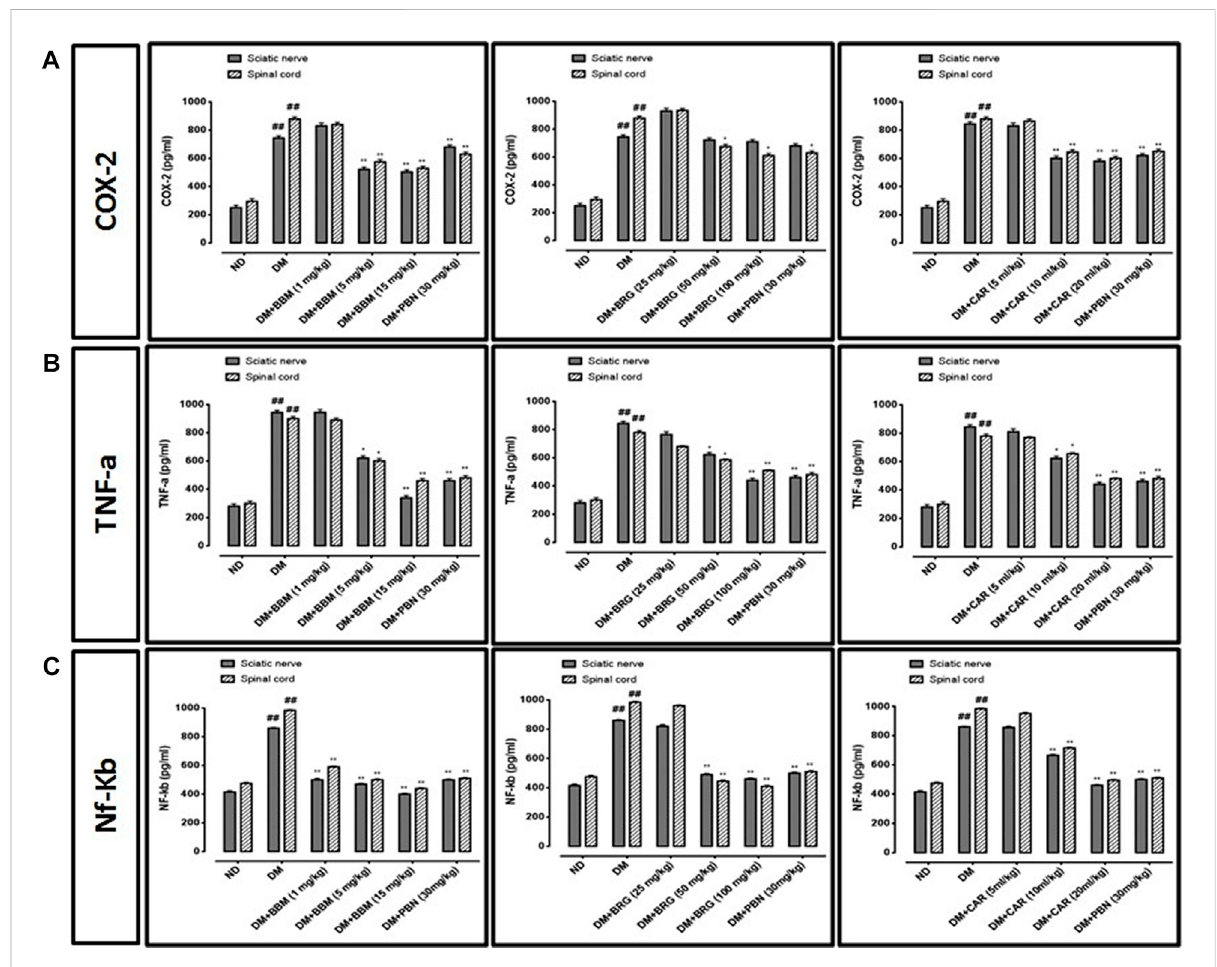
FIGURE 9 Represents the effect of berbamine, bergapten, carveol, and pregabalin on protein expression of (A) cyclooxygenase-2 (COX-2), (B) tumor necrosis factor- α (TNF- α ), and (C) nuclear factor kappa B (NF- κ b) in the sciatic nerve and spinal cord quanti fi ed by ELISA. Data expressed as mean ± SEM, ( n = 6). One-way ANOVA followed by post hoc Tukey test. ### p < 0.001 vs. non-diabetic (ND), * p < 0.05 and ** p < 0.01 vs. streptozotocin- induced diabetic neuropathy